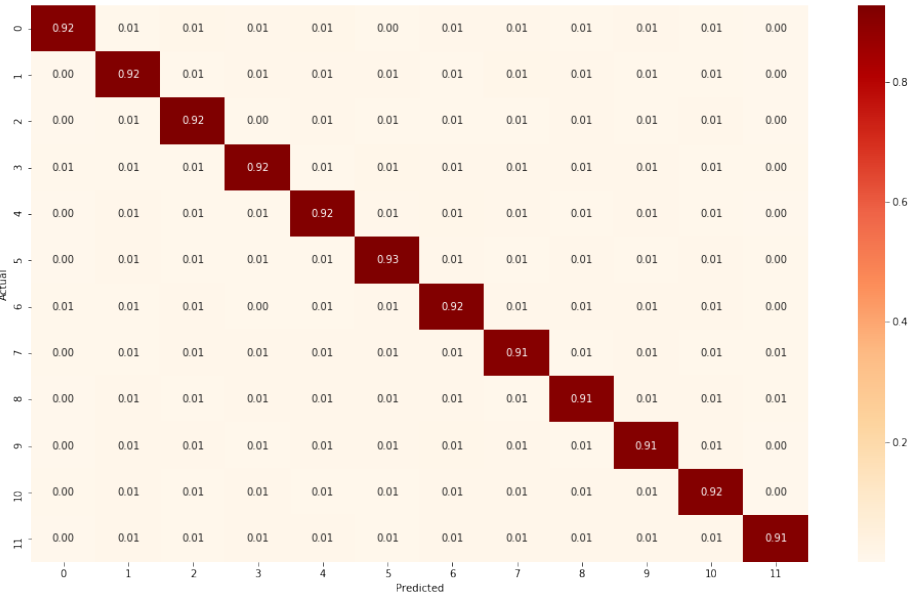
Figure 9. Confusion Matrix using IXMAS Dataset. Table 6. Classification report of proposed deep learning model(Precision, Recall and F1-Score) using IXMAS dataset.